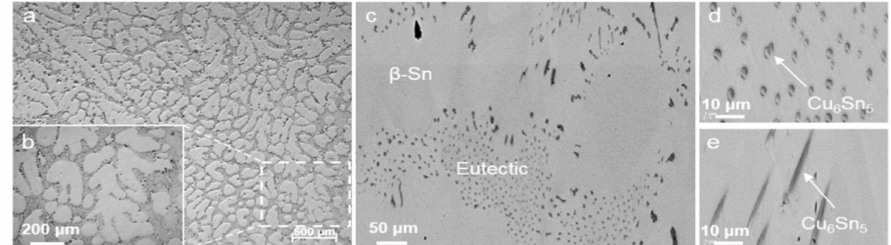
Figure 16. Micrograph and size of primary β -Sn dendrites, eutectic and intermetallic phase in F temper Cu-0.5 wt% alloy when observed under ( a , b ) OM, ( c – e ) SEM